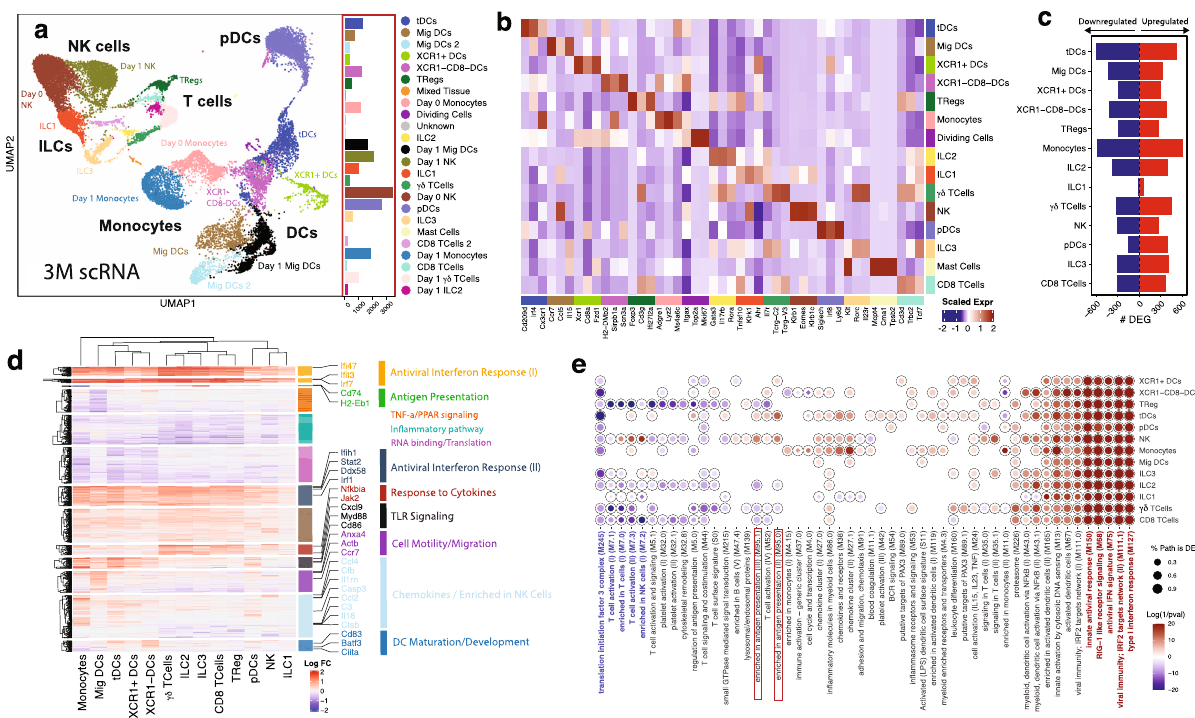
Fig. 2 3M-052-Alum/OVA induces a global anti-viral innate immunity program in draining LN 1 day post-immunization. a UMAP embedding of 21,664 cells classi fi ed by cell type. b Scaled expression of cell-type-speci fi c genes used to classify cells by type. c Number of upregulated (red) and downregulated (blue) genes in each cell type, FDR < 0.05 and absolute LogFC > 0.25. d Log fold change of genes from ( c ) across all cell types. Genes and cell types were k-means and hierarchically clustered. Functional groups of relevant gene clusters are highlighted. e BTMs signi fi cantly enriched (FDR < 0.001) after 1- day post-immunization with 3M-052-Alum/OVA. Overrepresentation analysis of the genes from ( c ) was used to determine signi fi cance. Adjusted P -values were measured using hypergeometric distribution with Benjamini Hochberg